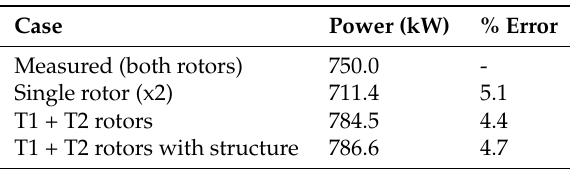
Table 3. Comparison of power output values.